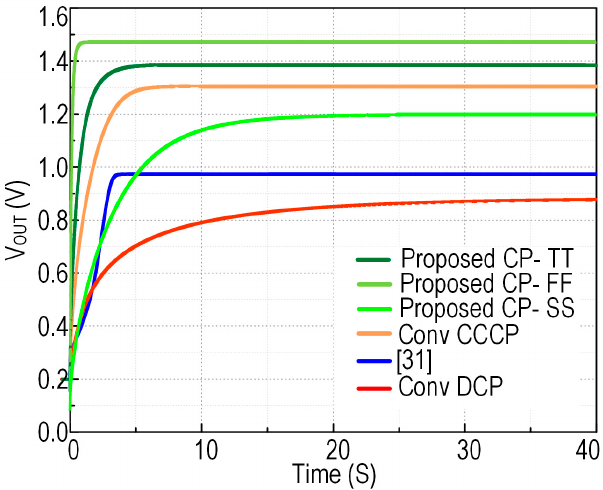
Figure 10. The transient output voltage of the proposed charge pump with prior art at V dd = 200 mV.